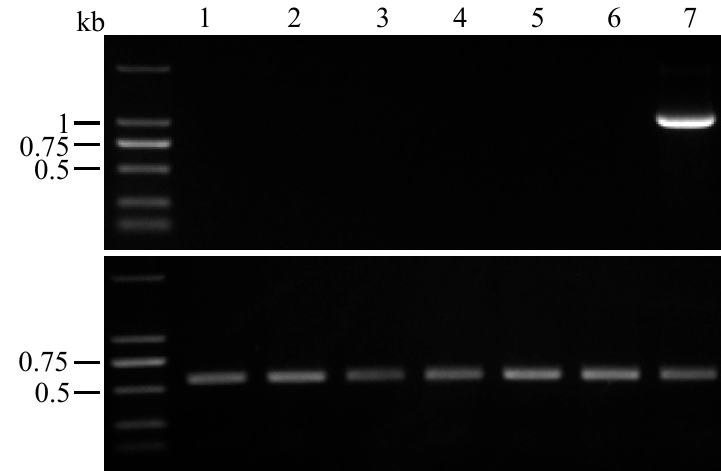
Figure 4. Verification of AfpyrG gene looping out. Upper panel: PCR was carried out using the primers targeting the AfpyrG marker. Lower panel: DNA template quality of the tested samples was validated using primers flanking the ITS region. The ∆ depH strain carrying the AfpyrG marker was set as positive control. (Lane 1–6: ∆ depH mutants without AfpyrG marker; Lane 7: positive control). The amdS gene encoding acetamidase from A. nidulans has been successfully used